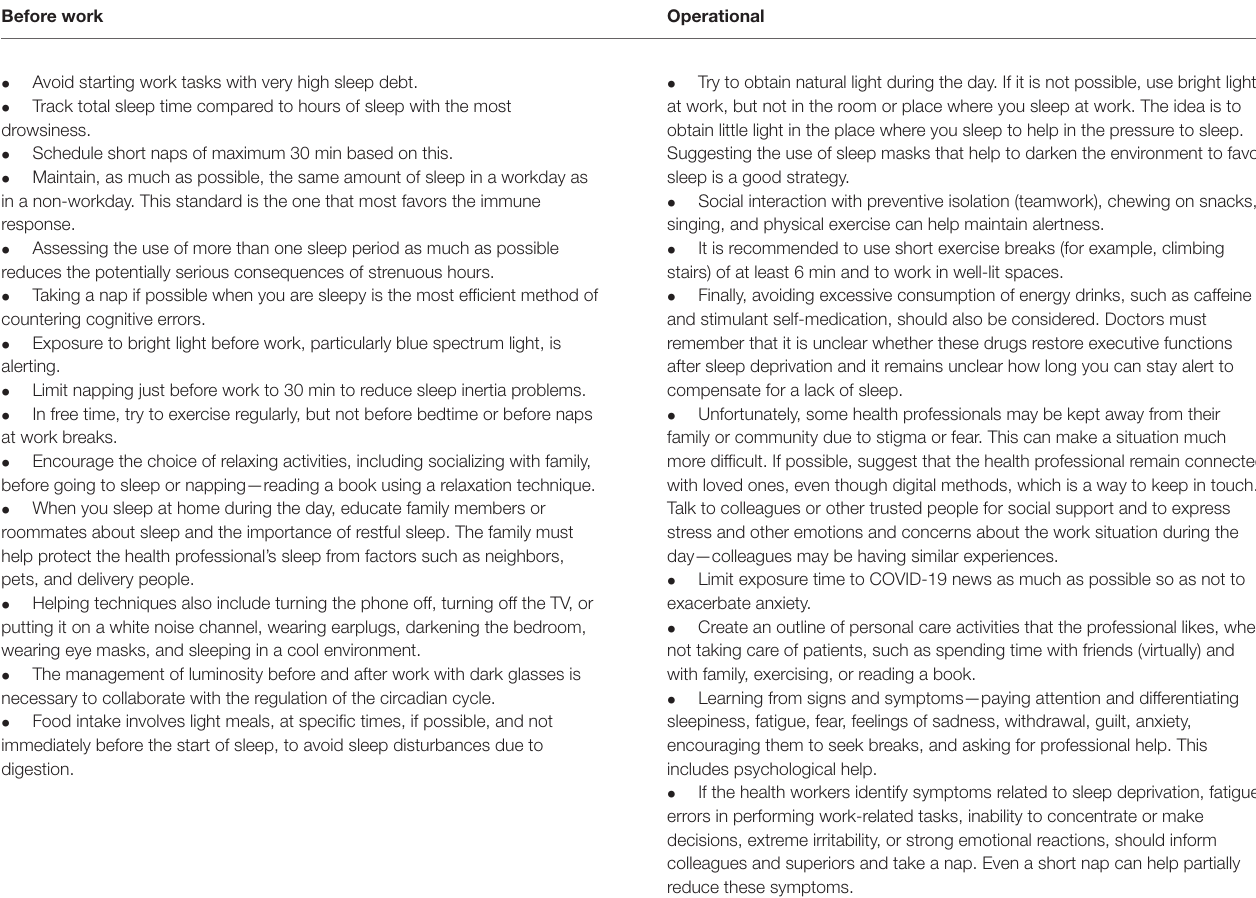
TABLE 2 | Behavioral and Cognitive measures for health professionals dealing with sleep problems during COVID-19. Before